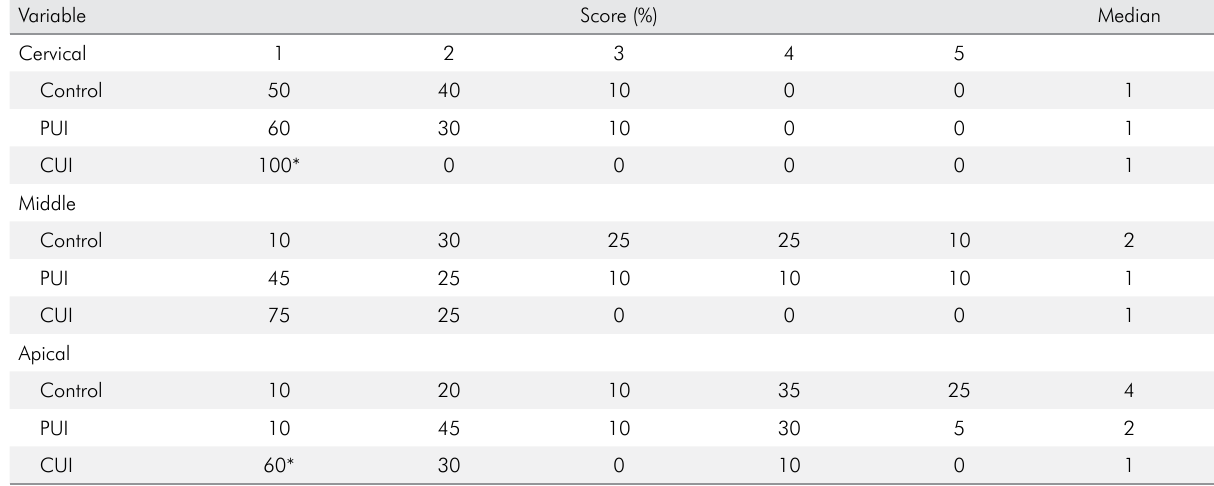
Table. Percentage of samples in each group categorized according to the 1-5 smear layer score and the median at the three analyzed canal